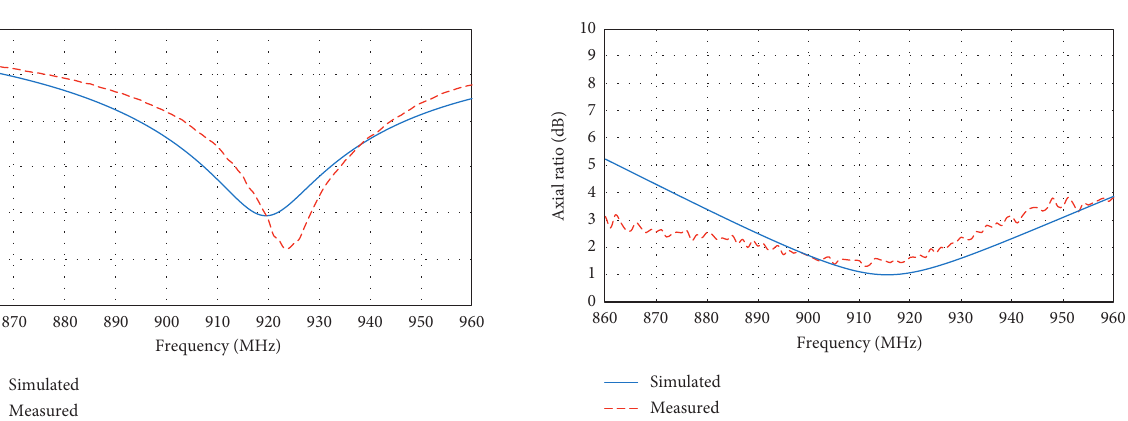
Figure 15: The simulated and measured | S antenna.